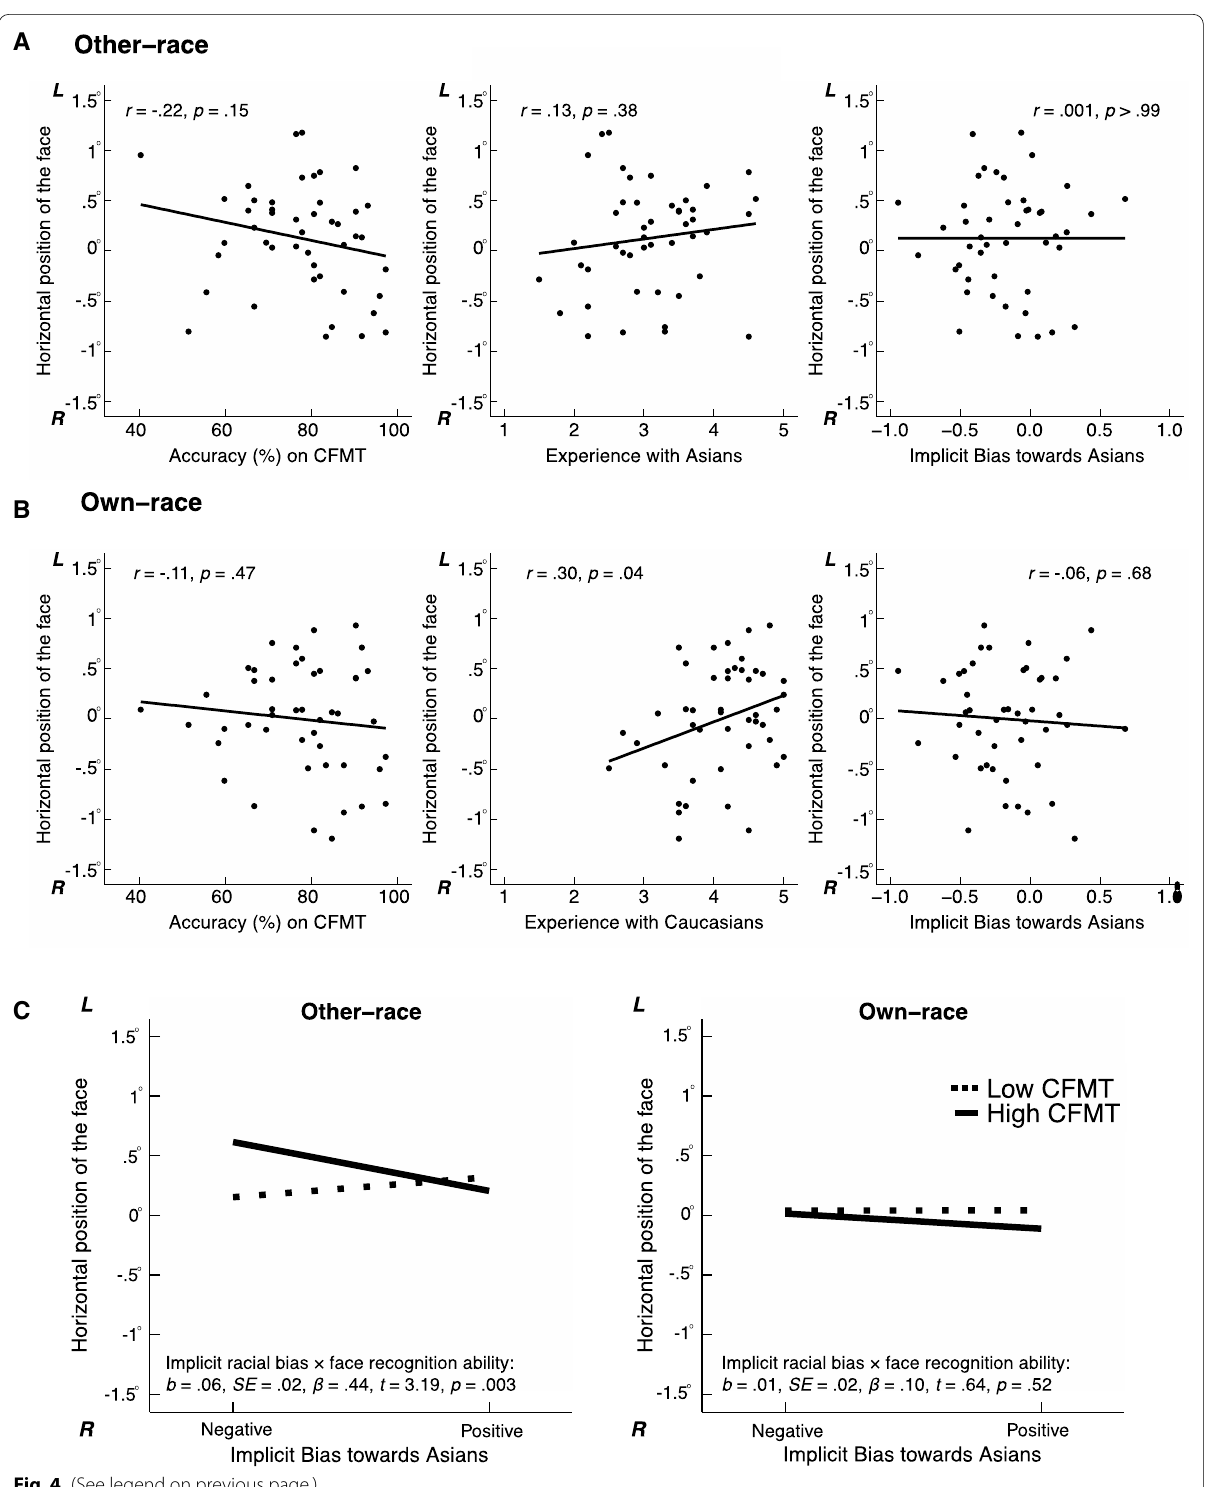
Fig. 4 (See legend on previous